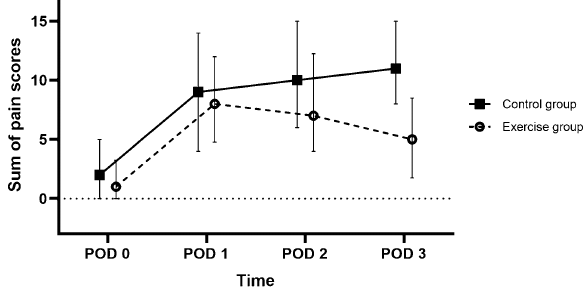
Figure 3. Time trend of the overall pain scores in the exercise and control groups. The data are shown as medians with interquartile ranges (error bars). The median pain scores gradually increased in the control group. Meanwhile, the median pain score increased on postoperative day (POD) 1 and then declined on POD 2–3 in the exercise group. The median total pain score (interquartile range) on POD 3 was 11 (8–15) and 5 (2–9) in the control and exercise groups,